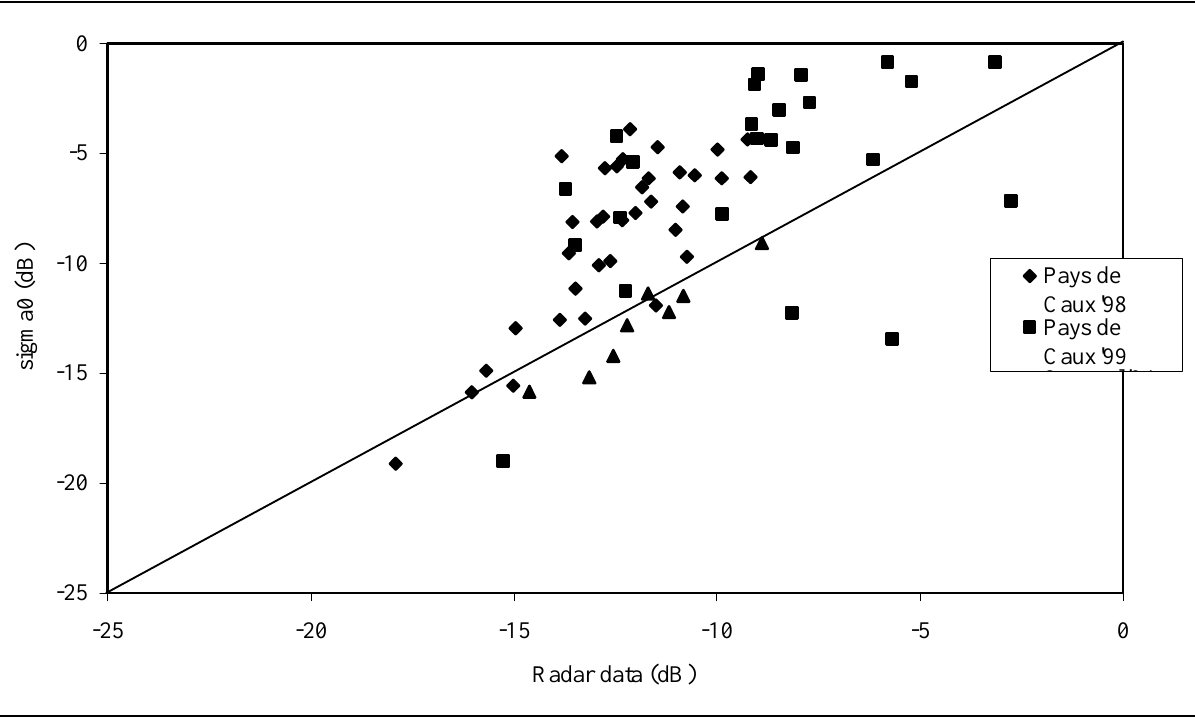
Figure 2. Inter-comparison between radar signal measurements and backscattering simulations as a function of soil